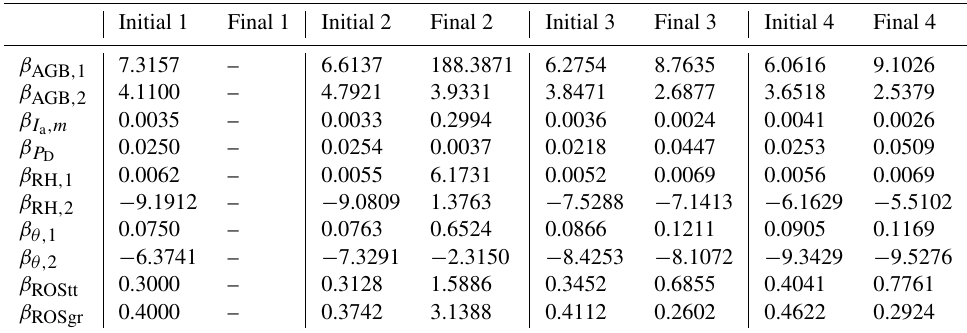
Table 3. Initial and final parameter sets for each optimization. Here, values are rounded to nearest 10 − 4 ; full-precision values can be found in Table S1 in the Supplement. Optimization 1 did not complete